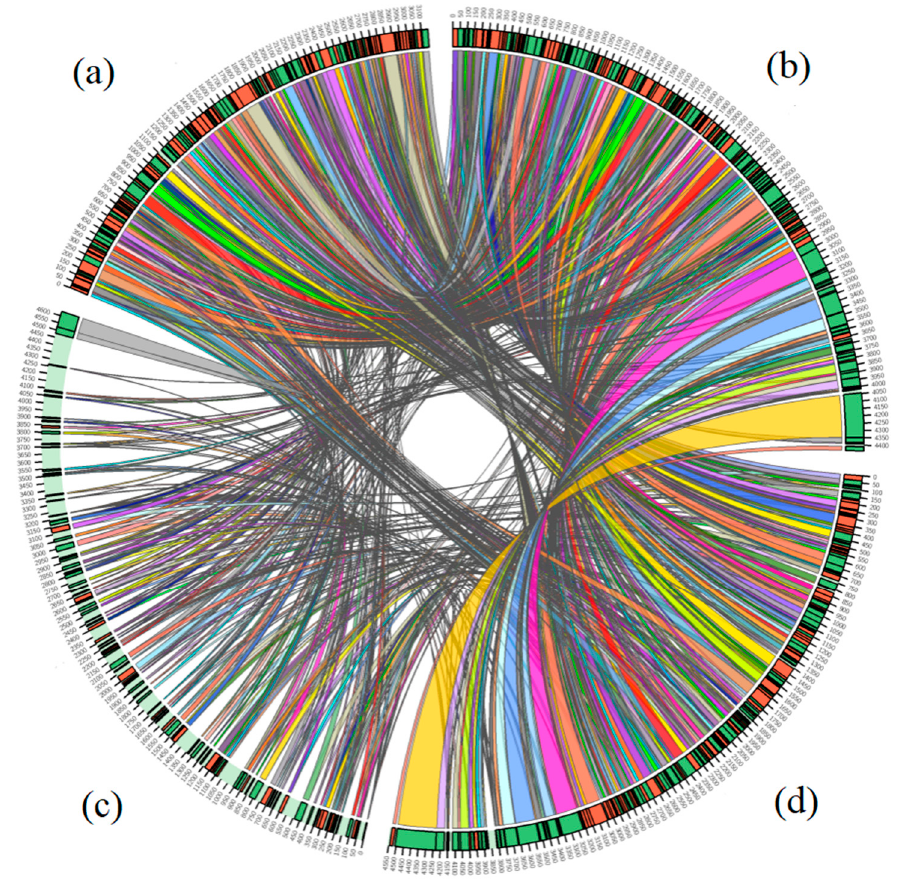
Figure 4. Genomic synteny shared between L. azotoformans KA25 T ( a ), strain EBL0706 ( b ), L. sphaeroides 2.4.1 T ( c ), and L. azotoformans ATCC 17025 ( d ).